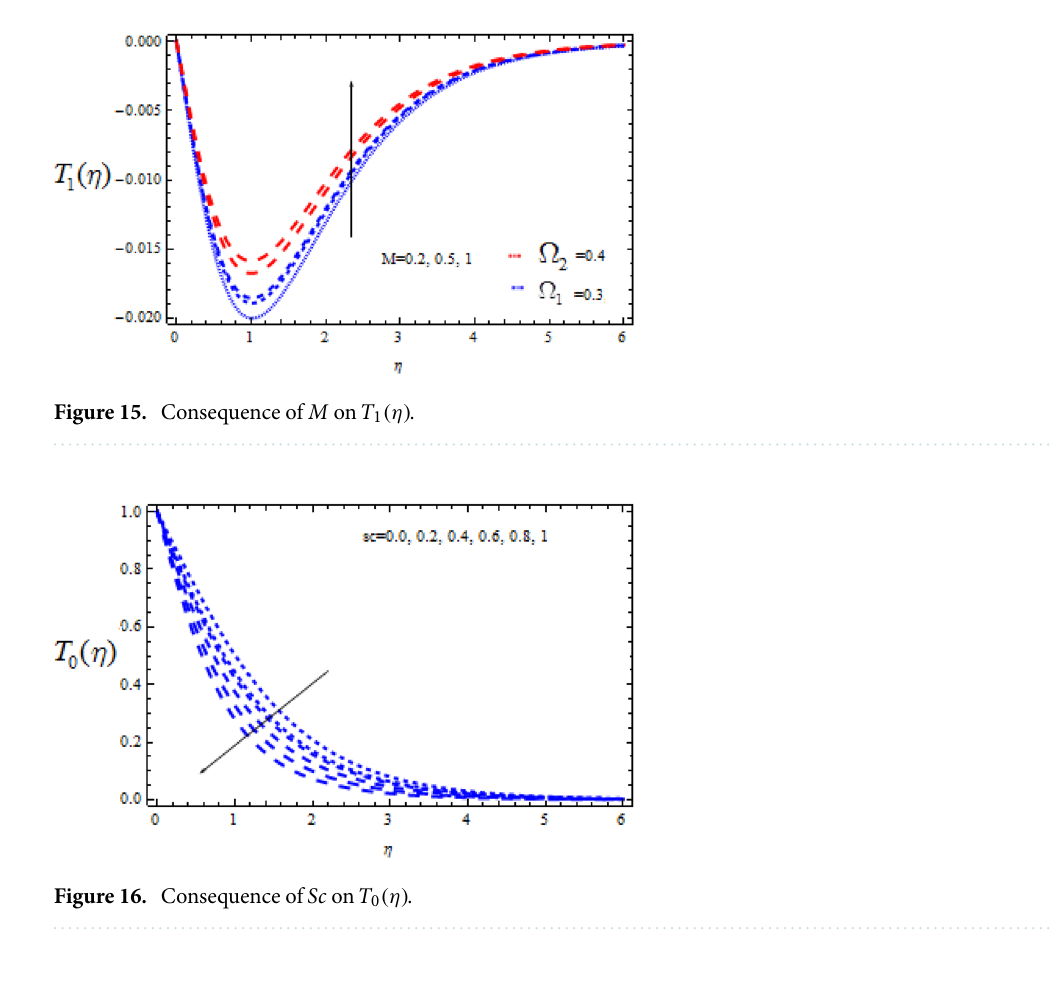
Figure 14. Consequence of M on T 0 (η) .